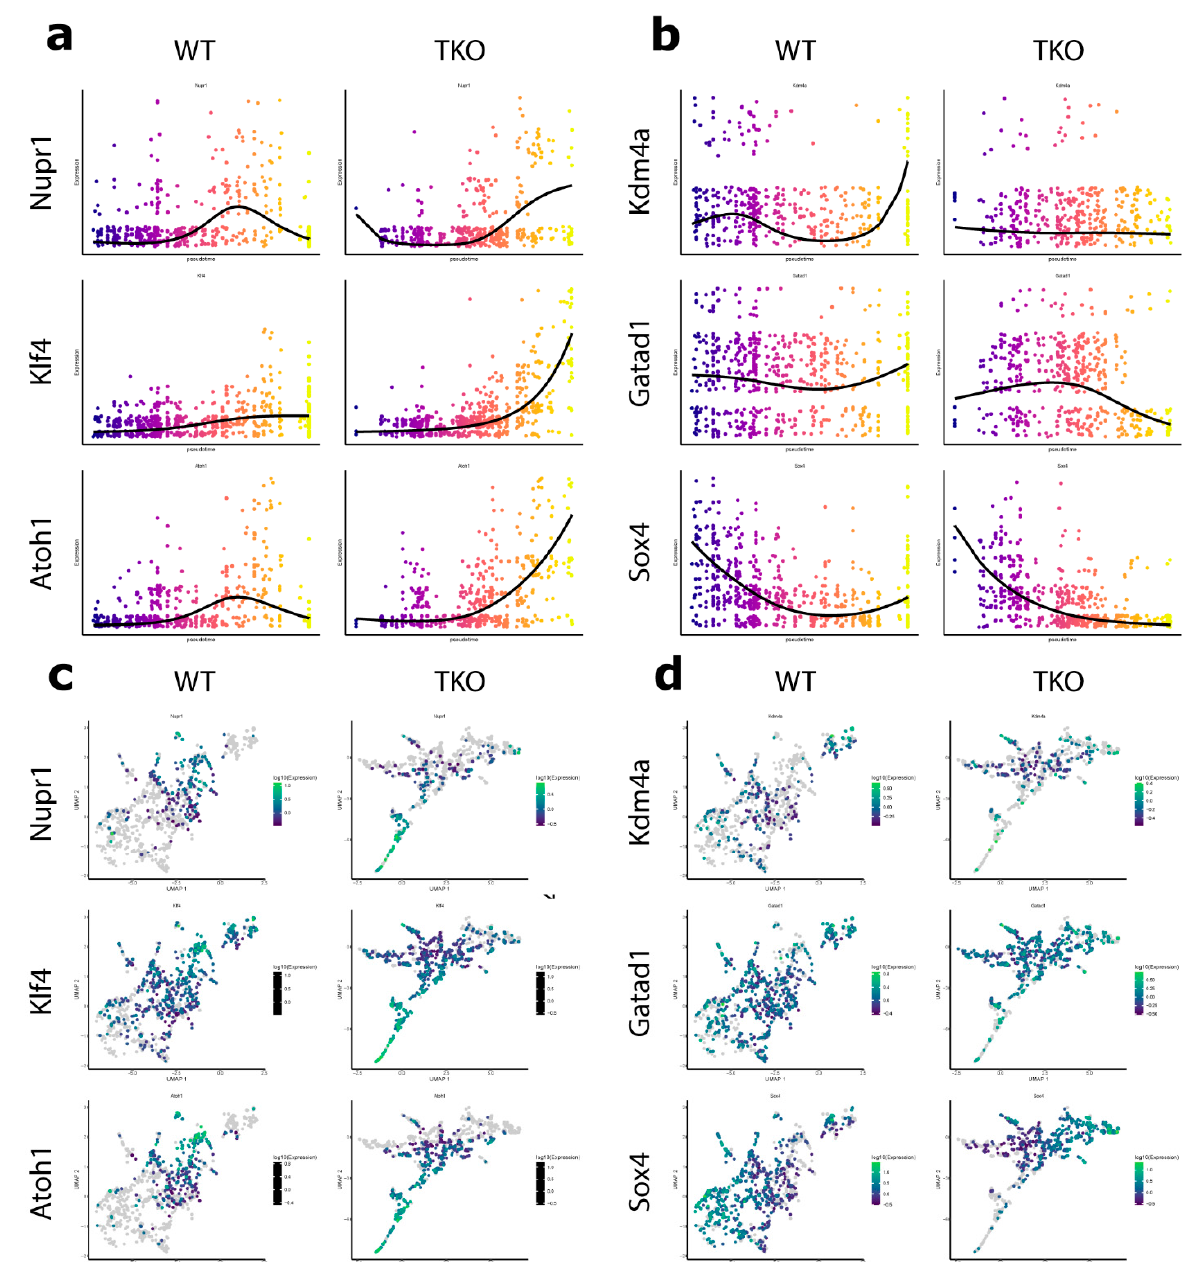
Figure 3. Genes differentially expressed across psuedotime in the secretory branch of TKO. ( a , c ) Plots of expression vs. pseudotime for genes upregulated ( a ) or downregulated ( c ) in TKO. Line represents the polynomial regression of expression vs. psuedotime. Cells are shown, colored by pseudotime (blue to yellow). Difference between the slope of TKO and WT fits is shown along with p-values; ( b , d ) UMAP of cell data set branch subsets. Cells are colored by expression of genes upregulated ( b ) or downregulated ( d ) in TKO. Cells are colored by gene